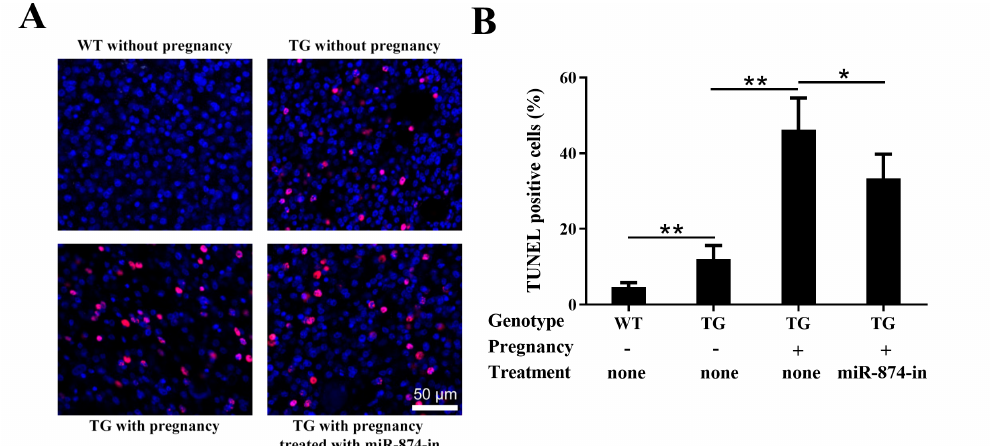
Figure 4. Inhibition of miR-874 ameliorated left ventricular cell apoptosis in PPCM of Gαq transgenic mice. (A) Representative TUNEL staining for detecting left ventricular cell apoptosis among different groups. Cells marked with red indicated apoptosis cells. (B) The percentage of apoptosis ratio among different groups from the TUNEL staining. Age-matched, female non-pregnant wild-type (WT, n=6) and Gαq transgenic mice (GT, n=6), pregnant Gαq transgenic mice (n=6) and Gαq transgenic mice treated with miR-874 antagonist (miR-874-in, n=6) were compared. Data are presented as mean ± SD. *p < 0.05, **p < 0.01 between the indicated groups.